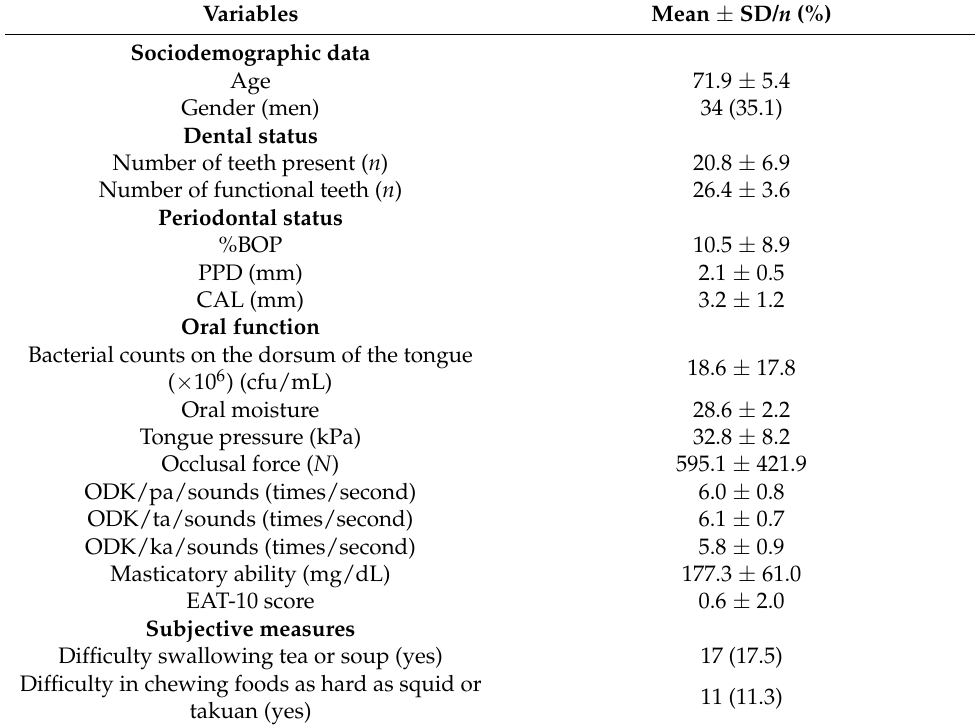
Table 1. Baseline characteristics ( n =